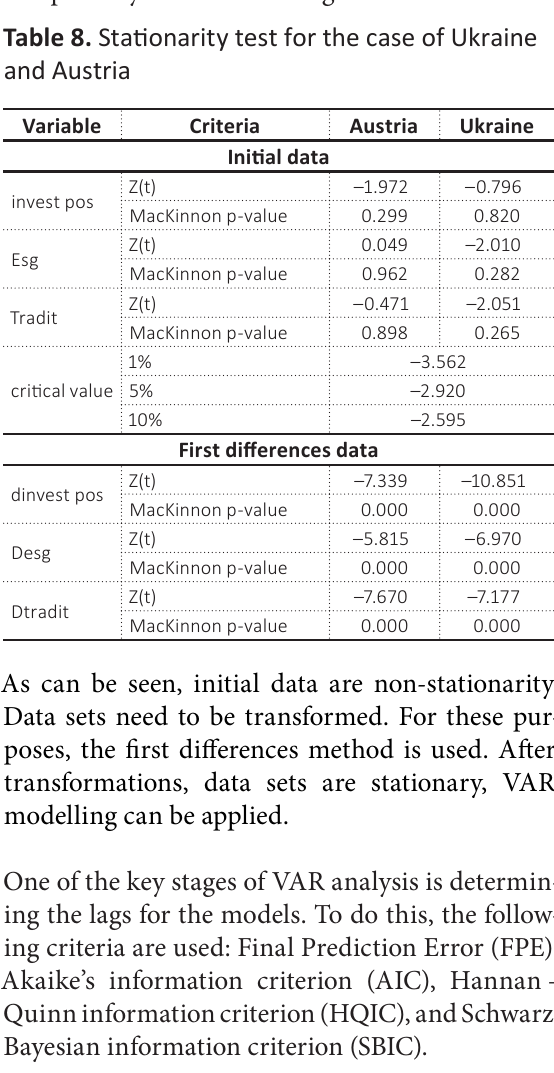
Table 8. Stationarity test for the case of Ukraine